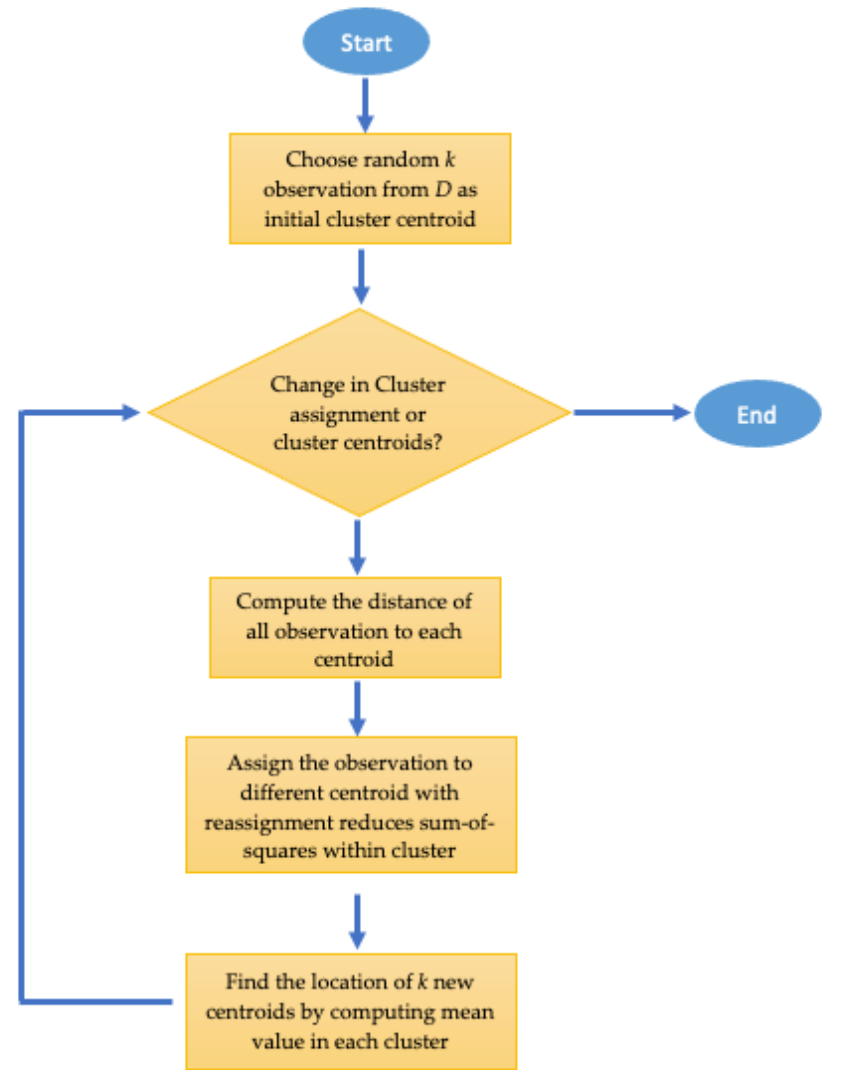
Figure 16. k-means algorithm method flowchart.